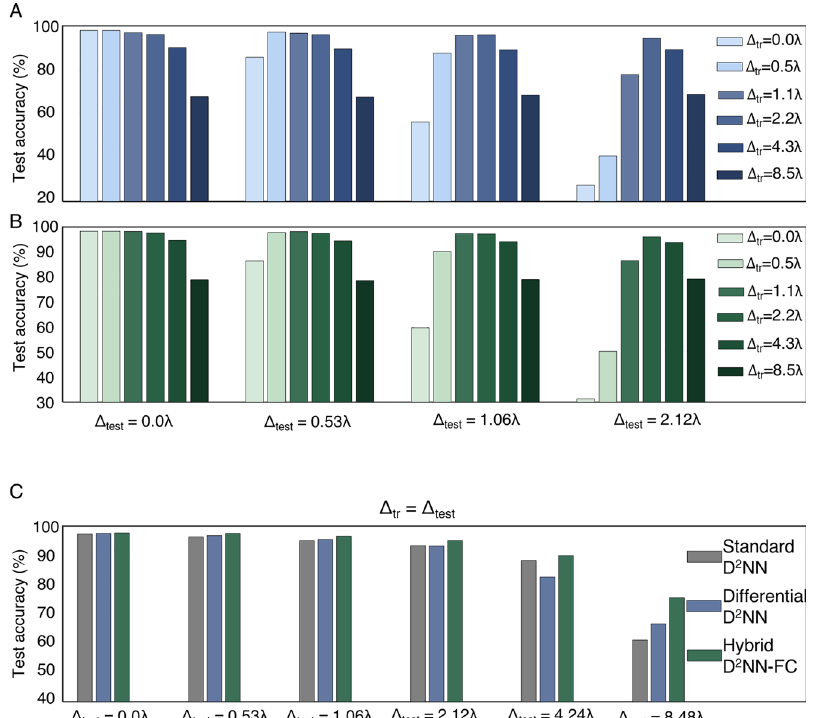
the vaccinated differential design (red curve) achieves 97.3% blind inference accuracy while the vaccinated standard diffractive network (blue curve) can provide 96.91% for the case Δ = Δ = 0.53 λ . In Figure 3I, where tr test